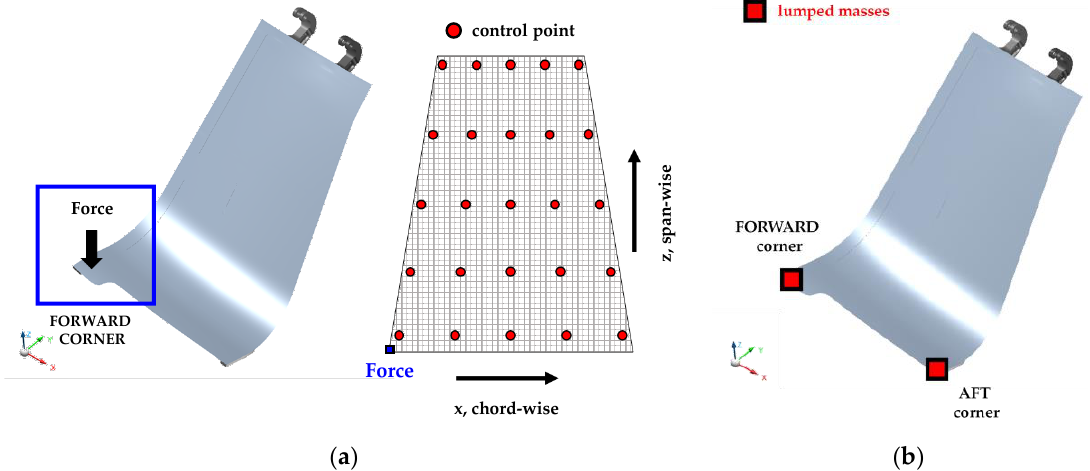
Figure 11. MLG door analysis setup: ( a ) dynamic load application and virtual acquisition points on MLG door; ( b ) ballast mass position.